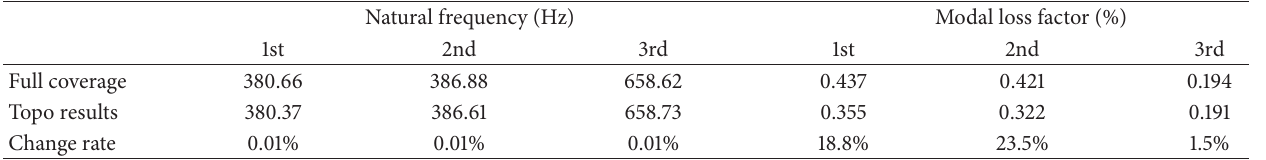
Table 4: Comparison of natural frequency and modal loss factor for two